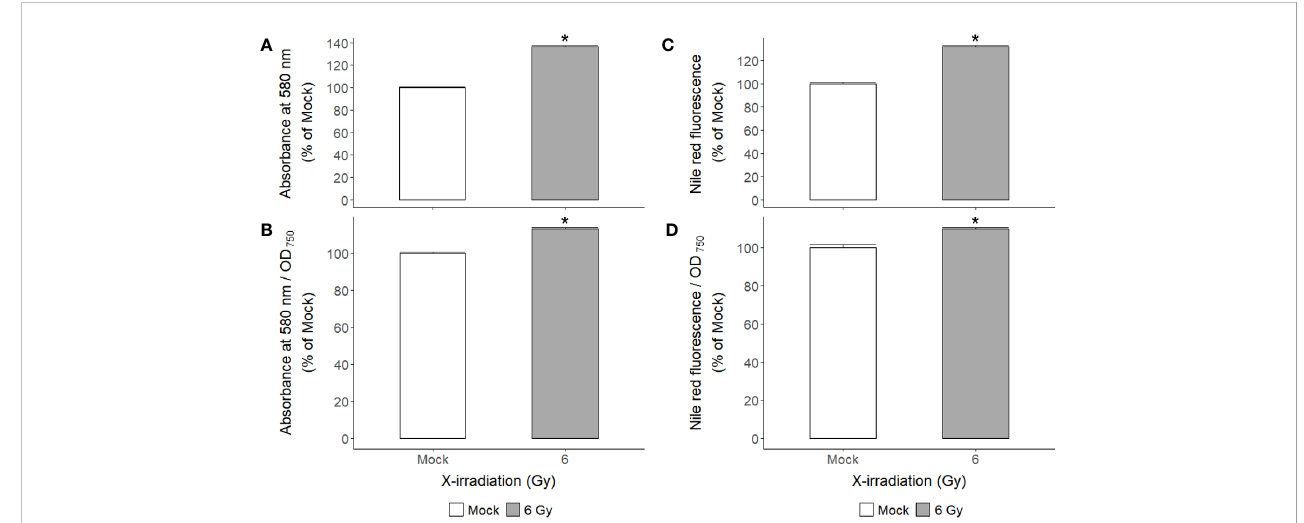
FIGURE 7 Changes in starch and lipid contents of C. reinhardtii cells after repetitive X-irradiation with 6 Gy. (A) The starch content was expressed relative to the mock by the absorbance at 580 nm after staining with the iodine reagent. (C) The lipid content was calculated relative to the mock by the signal at excitation 560 nm and emission 635 nm after staining with the Nile Red reagent. (B, D) The observed values were normalized against cell density (OD 750 ) to get the starch or lipid content in the same number of cells and then expressed relative to the mock. Data represent the mean ± standard error (SE) with n = 9 from three independent experiments. Asterisks indicate signi fi cant differences between mock (white bars) and irradiated samples (gray bars) based on a two-sample independent t -test ( p <